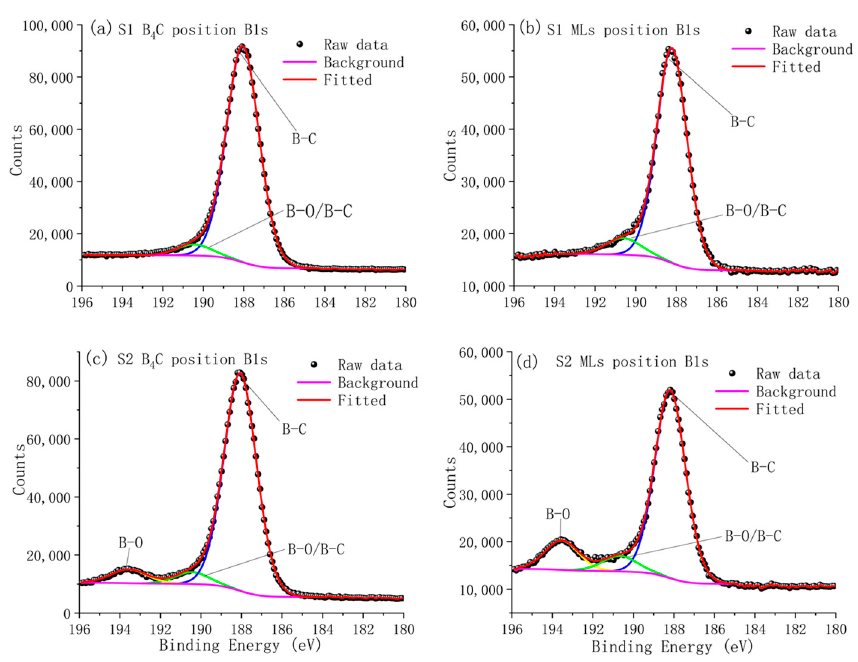
Figure 8. Measured and fitted B1s photoelectron spectra from the S1 and S2 sample. Figures ( a , c ) show the chemical state of boron in the B 4 C capping layer in samples S1 and S2, respectively. Figures ( b , d ) show the chemical state of boron in the multilayer in samples S1 and S2, respectively.